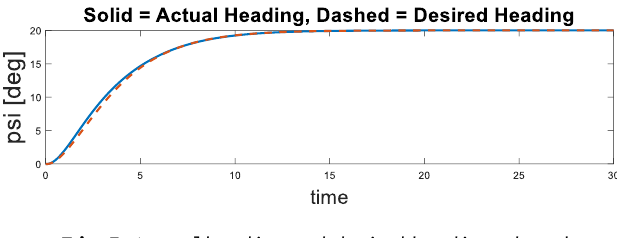
Fig. 5. Actual heading and desired heading when the vessel turns at an angle of 20 o